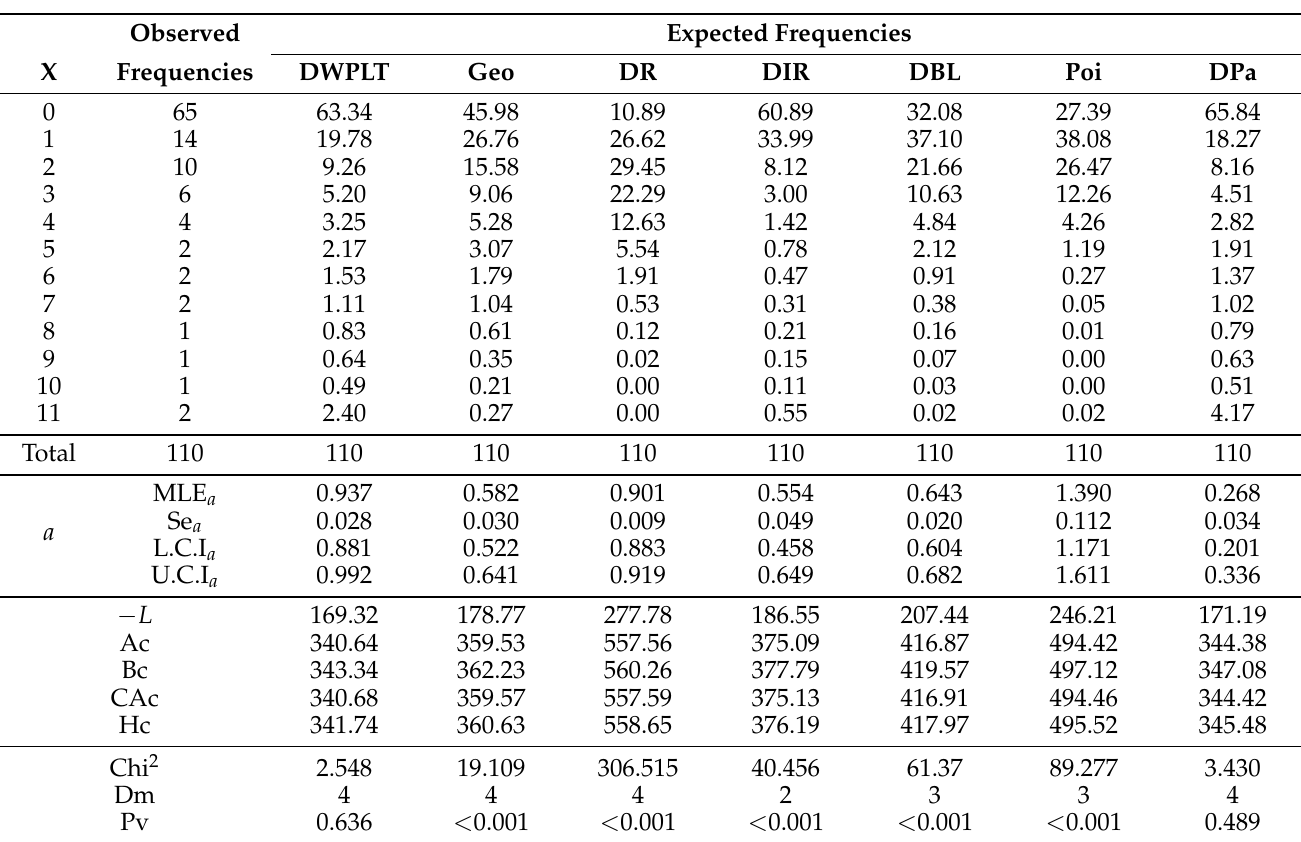
Table 3. GOFM for the dataset—Part I.